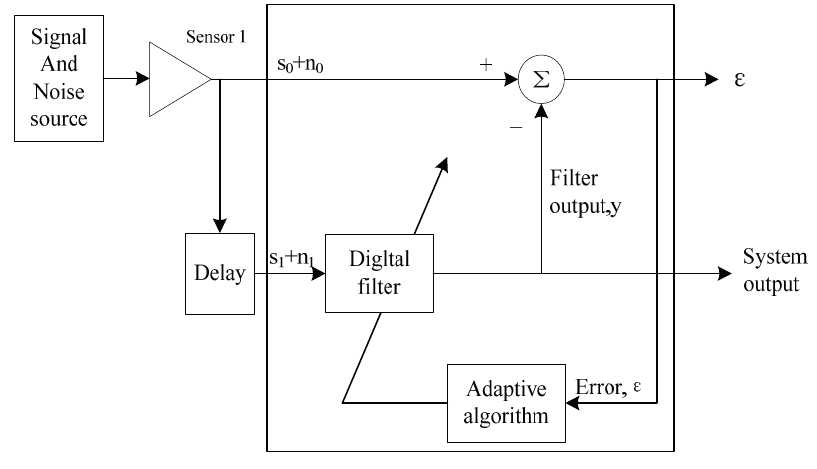
Figure 6. Block diagram of Adaptive Line